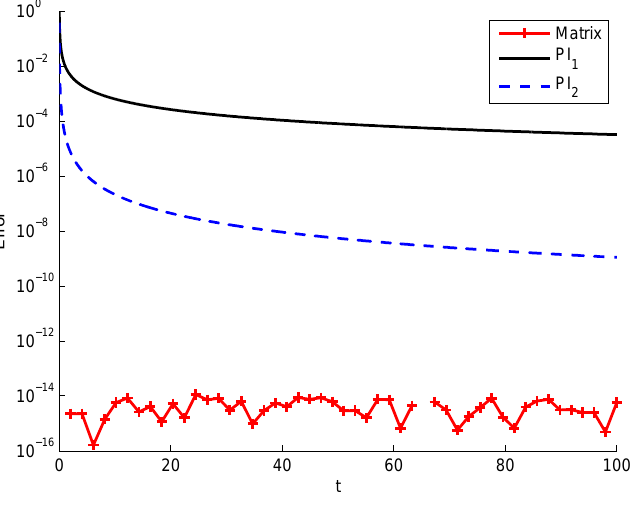
Figure 5. Relative error for the matrix approach and the product integration (PI) methods compared with the exact solution for α = 0.4 for Equation